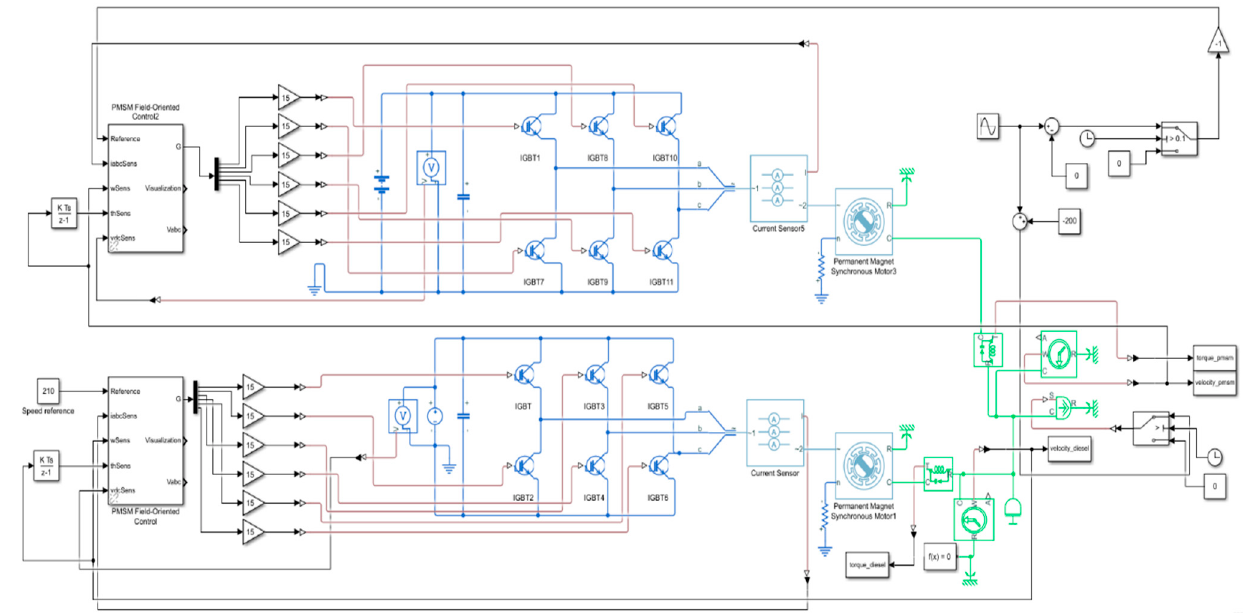
Figure 13. Simulation model in the Matlab/Simulink with two PMSM controlled by FOC (field-oriented control).